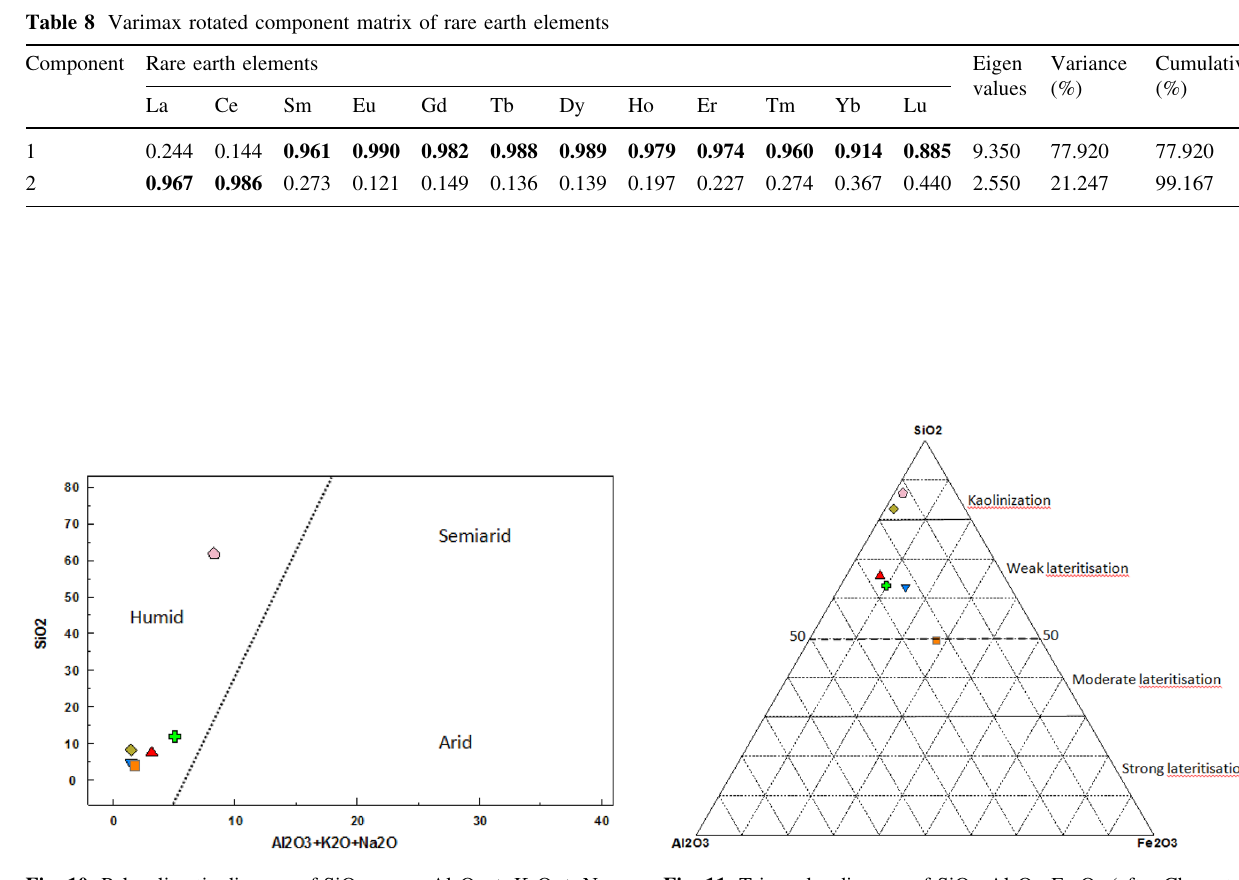
Fig. 11 Triangular diagram of SiO 2 –Al 2 O 3 –Fe 2 O 3 (after Chen et al.